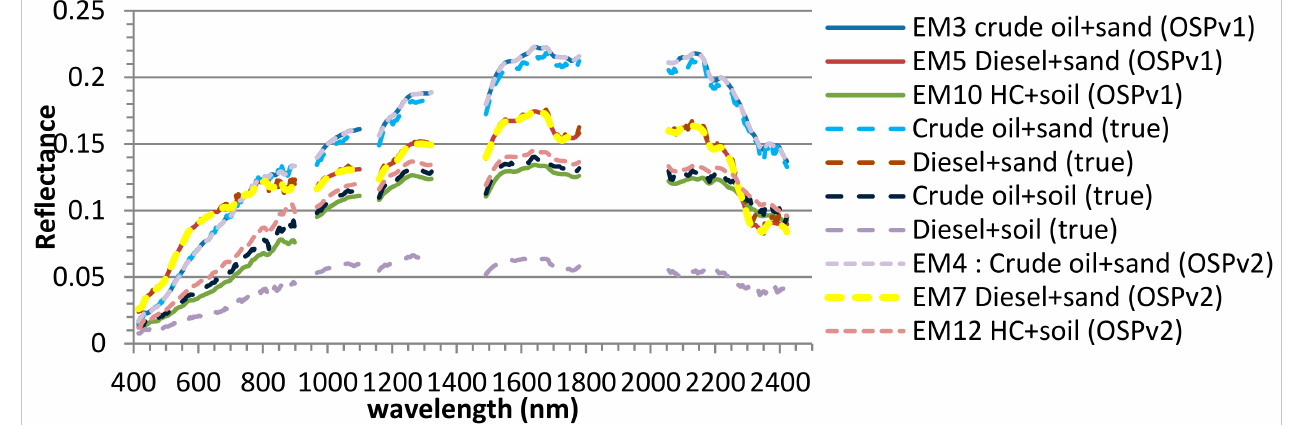
Figure 7. Endmembers associated with the HC-based mixtures compared with the true HC-mixture spectra (cases OSPv1 and